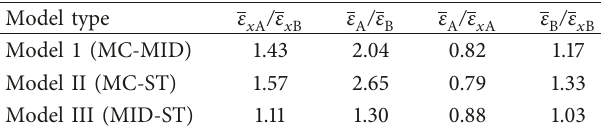
Table 3: The comparison of strain in each grain of the incompatibility models.